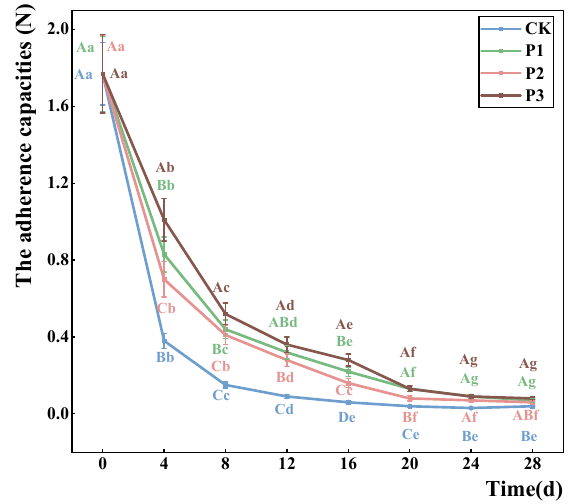
Figure 4. Soil’s adherence to the minerals in the pot experiment. Different capital letters indicate a significant difference ( p < 0.05) across treatments simultaneously based on a one-way analysis of variance and the Duncan test. Different lowercase letters denote significant differences ( p < 0.05) between different timepoints applied to the same bacteria.